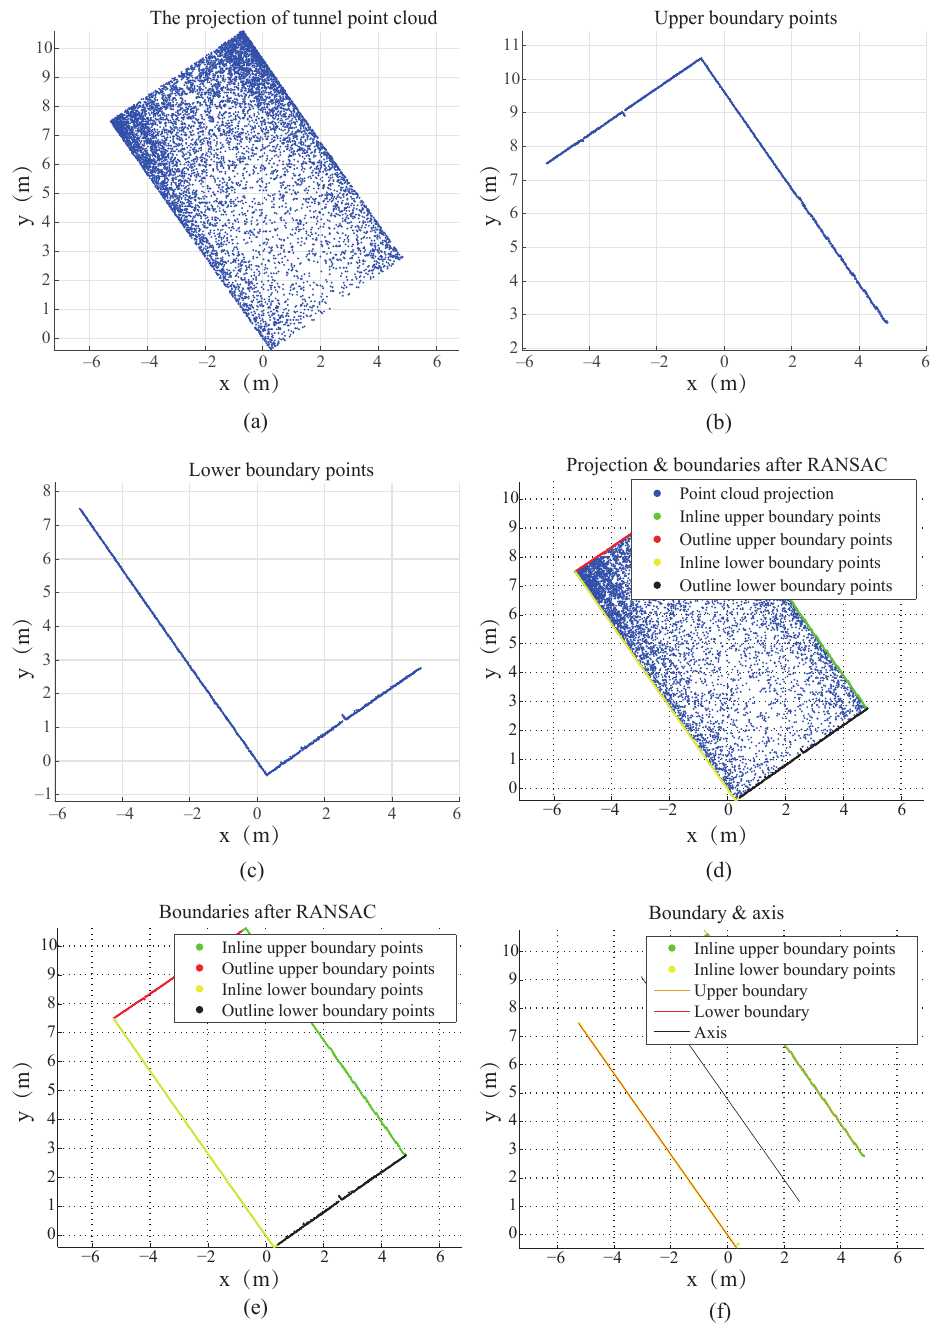
Figure 8. The sketch of every single step in tunnel axis acquisition: ( a ) is the projection of the compressed tunnel point cloud in the XOY plane; ( b ) illustrates the upper points extracted from every point cloud interval from xmin to xmax ; ( c ) illustrates the lower boundary points extracted from every point cloud interval from xmin to xmax ; ( d ) illustrates the point cloud projection and all boundaries including inline and outline upper boundaries and inline and outline lower boundaries fitted through the points extracted in ( b , c ) by Random Sample Consensus (RANSAC); ( e ) illustrates all boundaries fitted through the boundary points by RANSAC; ( f ) extract the inline upper and lower boundaries and the axis extracted from the inline